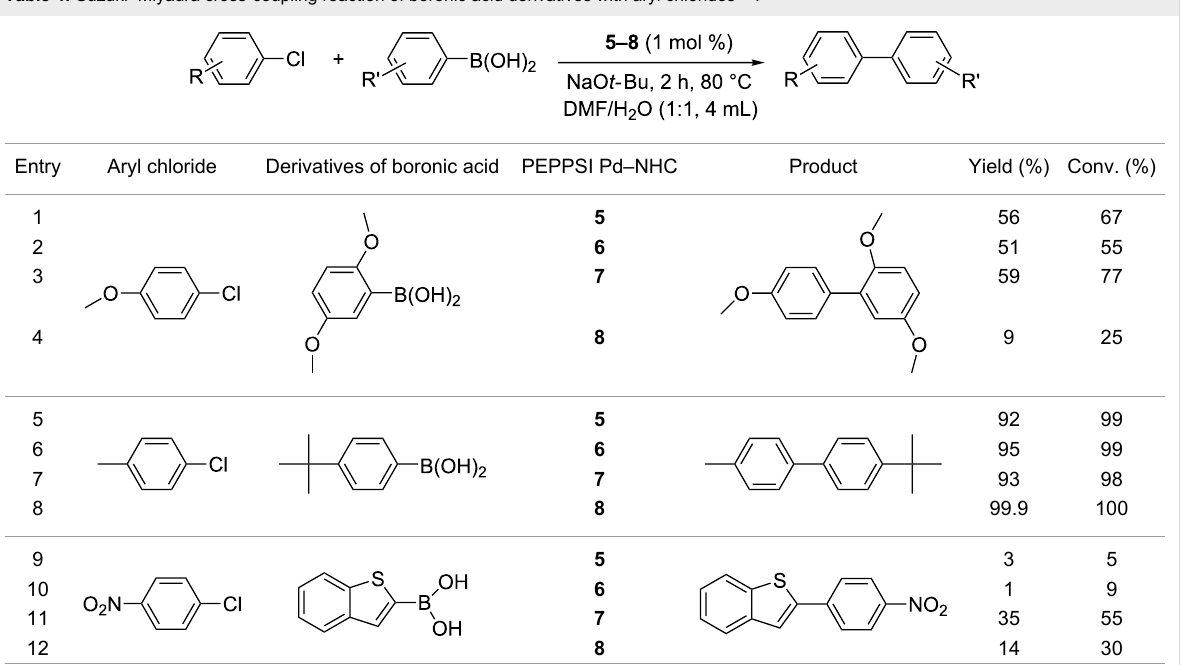
Table 4: Suzuki–Miyaura cross-coupling reaction of boronic acid derivatives with aryl chlorides a,b .